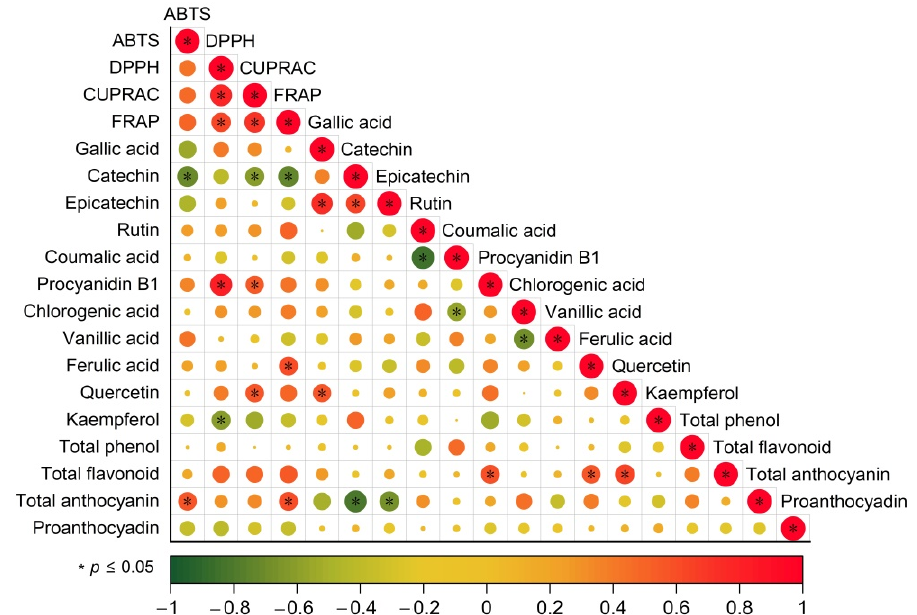
Figure 5. The correlation between phenolic compounds and antioxidant activity. Strong and weak correlations are indicated by the large and small circles, respectively. The color of the scale bar denotes the nature of the correlation; 1 indicates a perfect positive correlation (red) and -1 indicates a perfect negative correlation (green). Significant correlations p ≤ 0.05) is indicated by *.